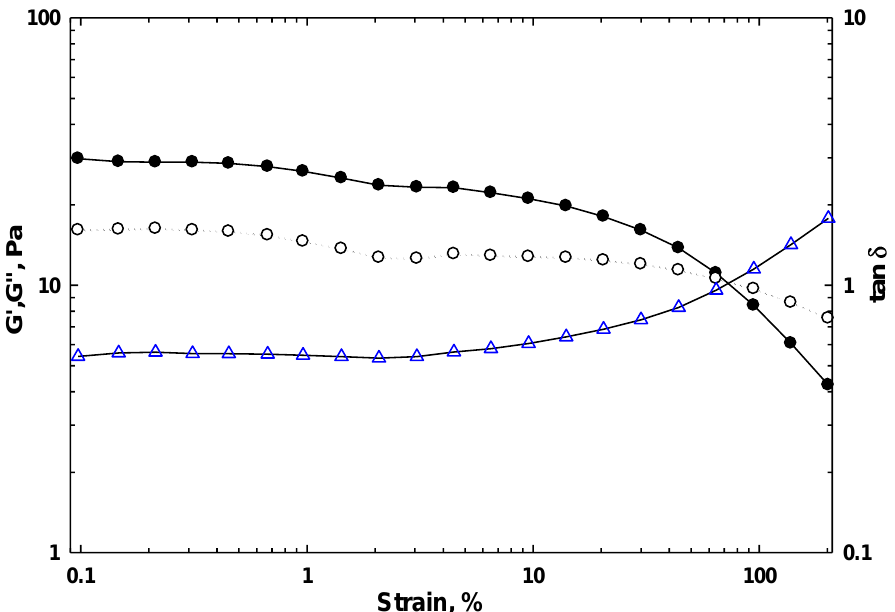
Figure 2. Storage modulus (G ’, solid symbol), loss modulus (G″, blank symbol), and loss tangent (tan δ, blue symbol) of SISH dispersions at 1% concentration determined by strain amplitude sweep tests as a function of strain amplitude from 0.1% to 150% at a constant frequency of 1.0 Hz. The effect of hydrocolloid concentration on the storage modulus (G ’ ), loss modulus (G ” ), critical strain (γ 0 ), yie ld stress (τ c ), and loss tang ent (tan δ) of SISH dispersions within the LVE region are summarized in Table 2. Both G’ LVE and G” LVE values at the LVE region also increased over increasing concentrations of SISH in dispersions (Table